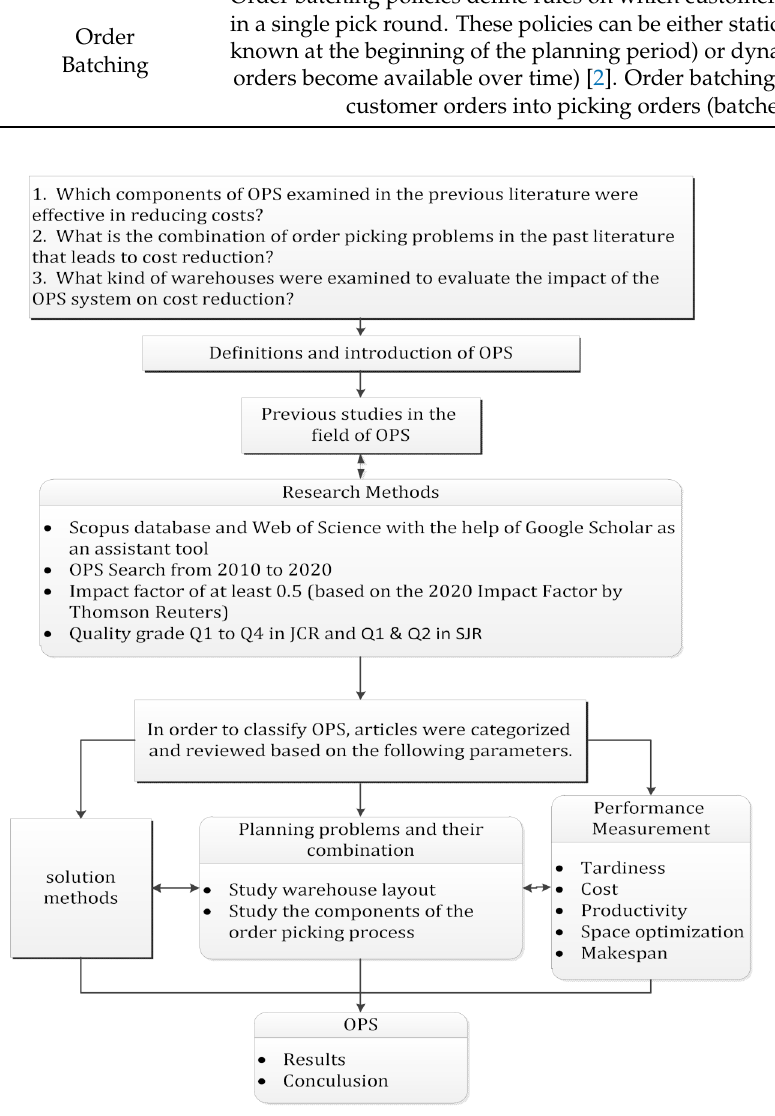
Figure 2. Proposed classification to review the OPS